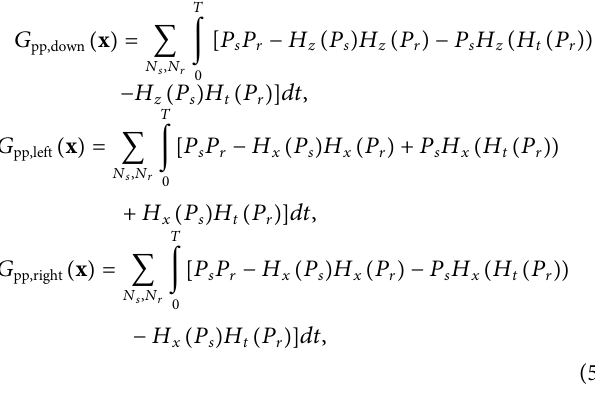
axis (i.e., the long offset effect), δ describes the near-symmetry- axis qP-wave velocity variation (i.e., the short offset effect), and θ is the tilt angle of the TTI symmetry axis.